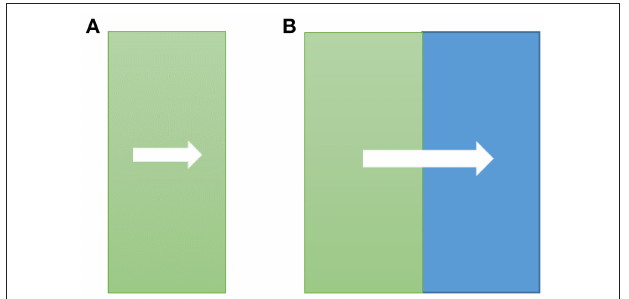
FIGURE 2 | Schematic of cross-plane phonon transport across the single-layer thin film and cross-plane interfacial phonon transport across the bi-layer thin film: (A) the single-layer thin film made of Si and Ge separately; (B) the bi-layer thin film made of Ge/Si.